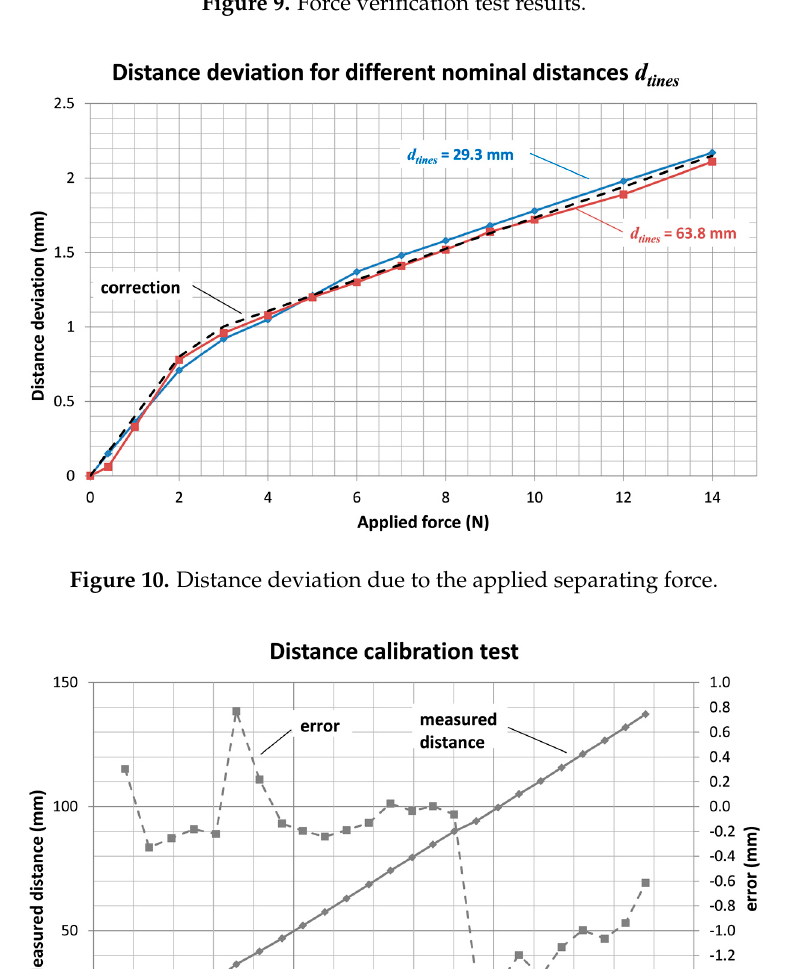
Figure 9. Force verification test results.